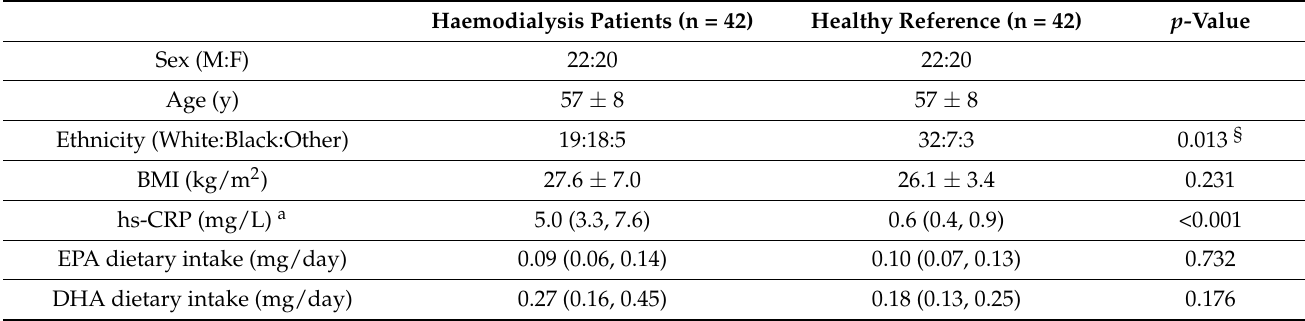
Table 2. Comparison of LC n -3 PUFA status and intake, sleep-time HRV and inflammatory marker in haemodialysis patients and age-, sex- and BMI-matched healthy controls from the MARINA